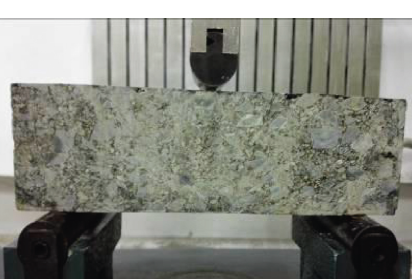
Figure 6: Bending test.